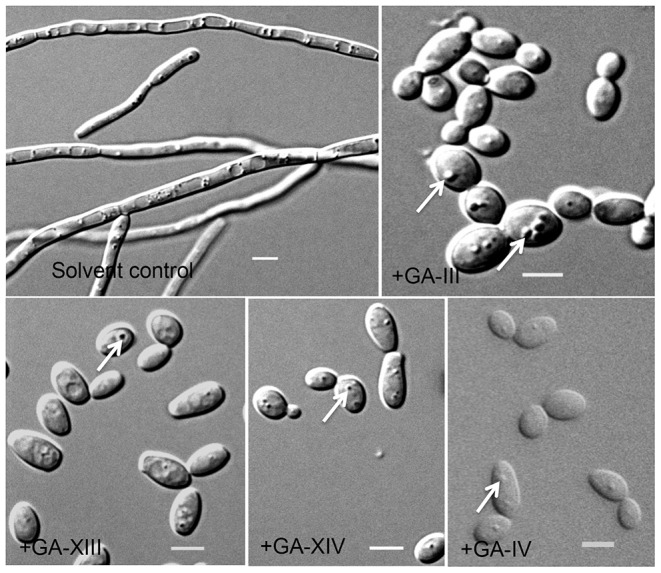
Inhibition of C. albicans yeast-to-hypha transition by individual GAs.
C. albicans yeast cells were incubated in hyphae inducing medium (RPMI) in microtiter wells without shaking at 37°C with the indicated GA for 16 h. Each GA was solubilized in 75% methanol and added to the yeast cell suspension at final concentrations of 60 µg/ml. The final concentration of solvent was <5%. Cells were monitored under microscope using 10x×63x objective (Zeiss) and images were recorded. Solvent control contains equal volume of 75% methanol. Arrows show vesicle like structures in yeast cells. Scale bars = 5 µm.